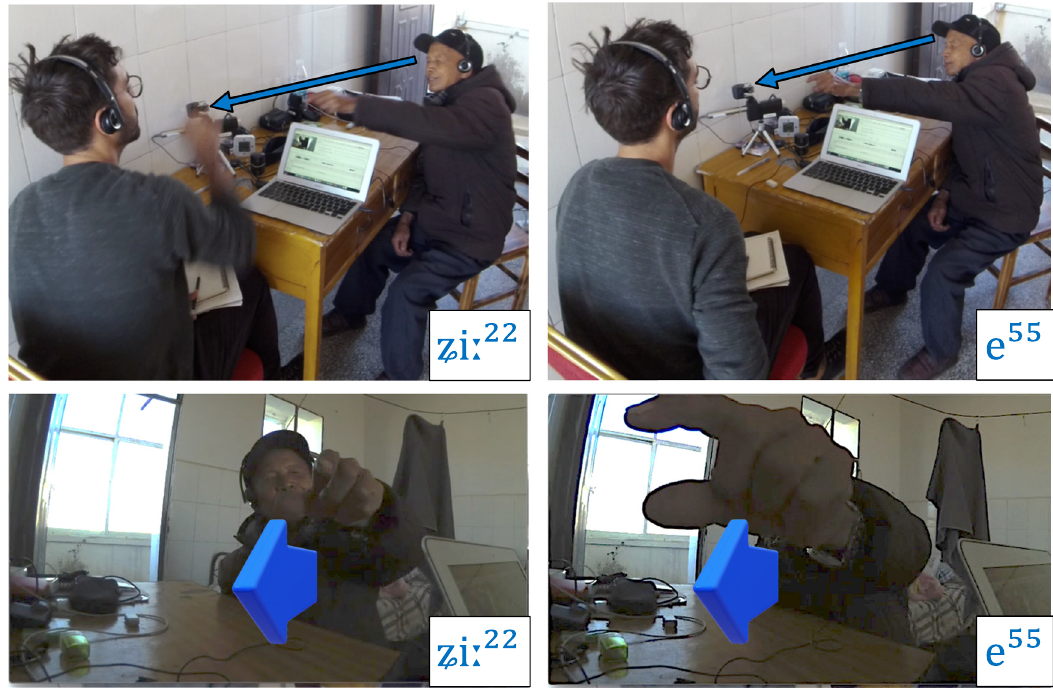
Figure 8: Speaker reclaims physical proximity to referent, prompting a switch to speaker - anchored deictics. Figures on top row and bottom row represent the exact same frames as captured by a lateral and a frontal camera, respectively. They correspond to the bolded tokens in Example